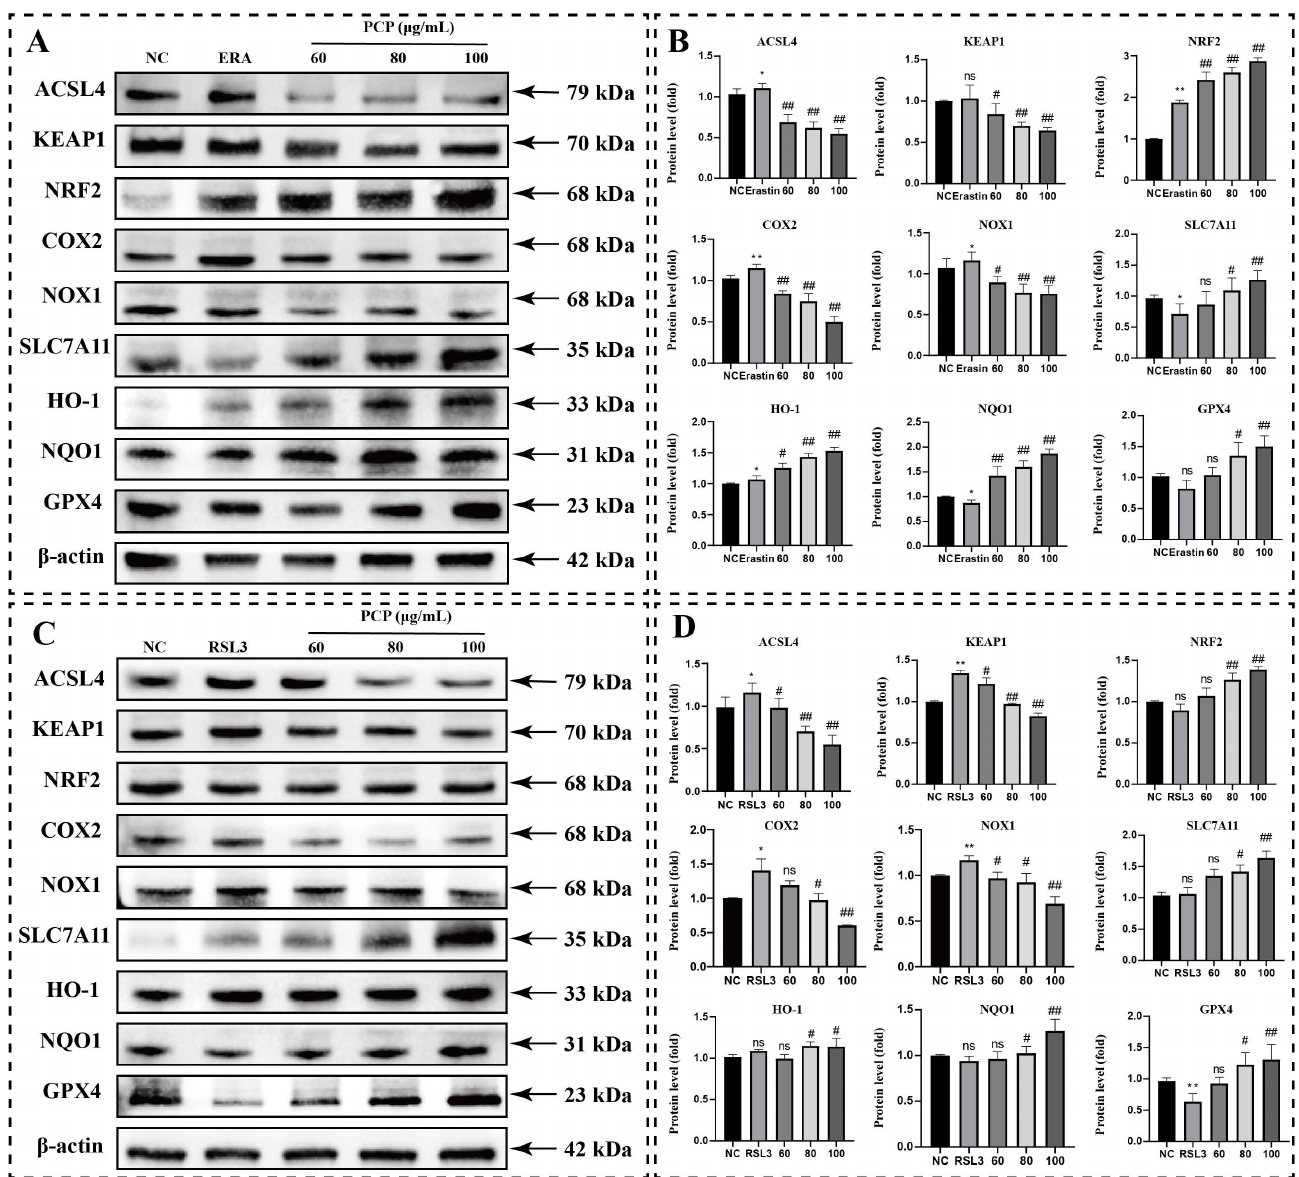
Figure 11. PCP upregulates the ferroptosis pathway in microglia. The cells were treated us- ing ERASTIN (200 µ mol) or RSL3 (1.5 µ mol) and PCP at different concentrations (0, 60, 80, and 100 µ g/mL) for 24 h. The NC group was set up as the control and treated with DMEM. Then, we measured the levels of the KEAP1, NRF2, ACSL4, COX2, NOX1, SLC7A11, HO-1, NQO1, and GPX4 proteins by Western blotting and measured the grey value using ImageJ. The KEAP1, NRF2, ACSL4, COX2, NOX1, SLC7A11, HO-1, NQO1, and GPX4 proteins after ERASTIN/RSL3 intervention ( A , C ). Statistics of protein’s grey value after β -actin standardization ( B , D ) (standardized with β -actin). ( ns p > 0.05, * p < 0.05, ** p < 0.01, # p < 0.05, and ## p <